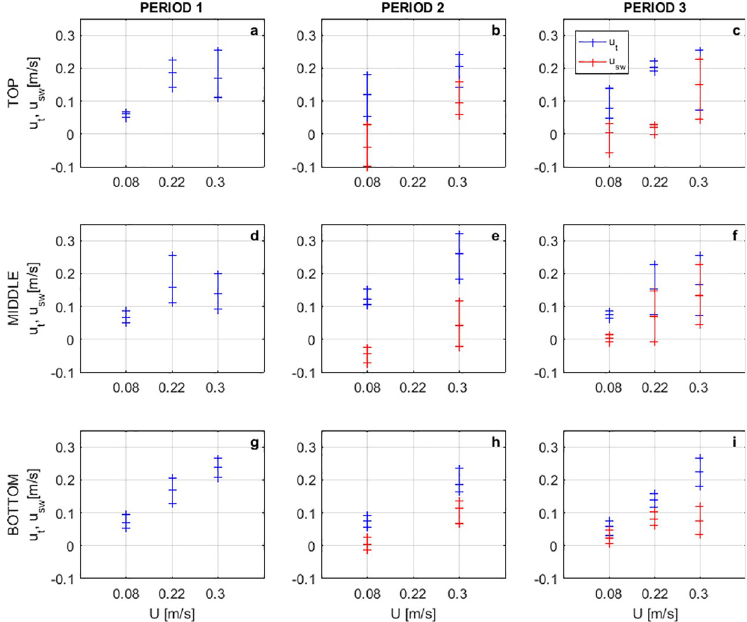
Fig 7. Ranges of horizontal traveling ( u t ) and swimming speeds ( u sw ). (a,d,g) Developmental period 1. (b,e,h) Developmental period 2. (c,f,i) Developmental period 3. For three regions considered across the water profile: top (a- c), middle (d-f), and bottom (g-i). Positive traveling speeds in the same direction of the flow. Positive swimming speeds against the direction of the flow.